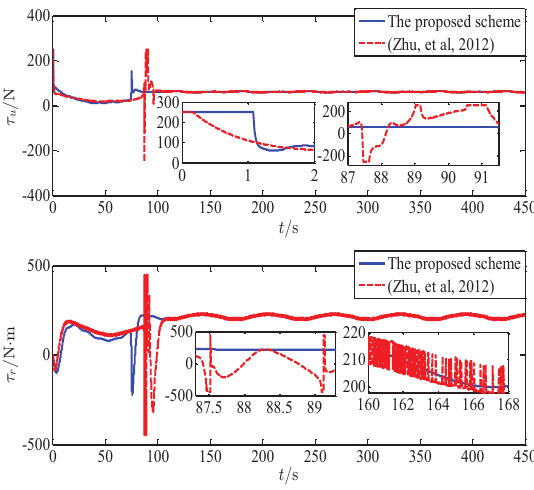
Figure 7. Control inputs of circular trajectory.